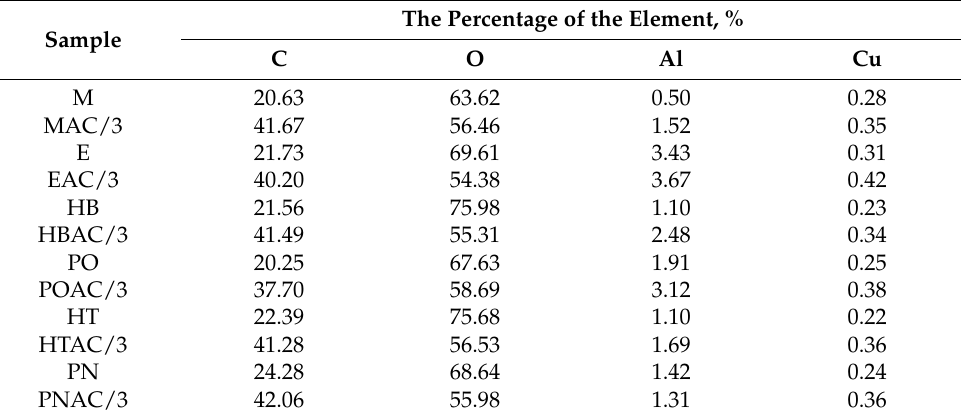
Table 2. Elemental compositions of the raw materials and the activated carbons, as determined with SEM-EDX.